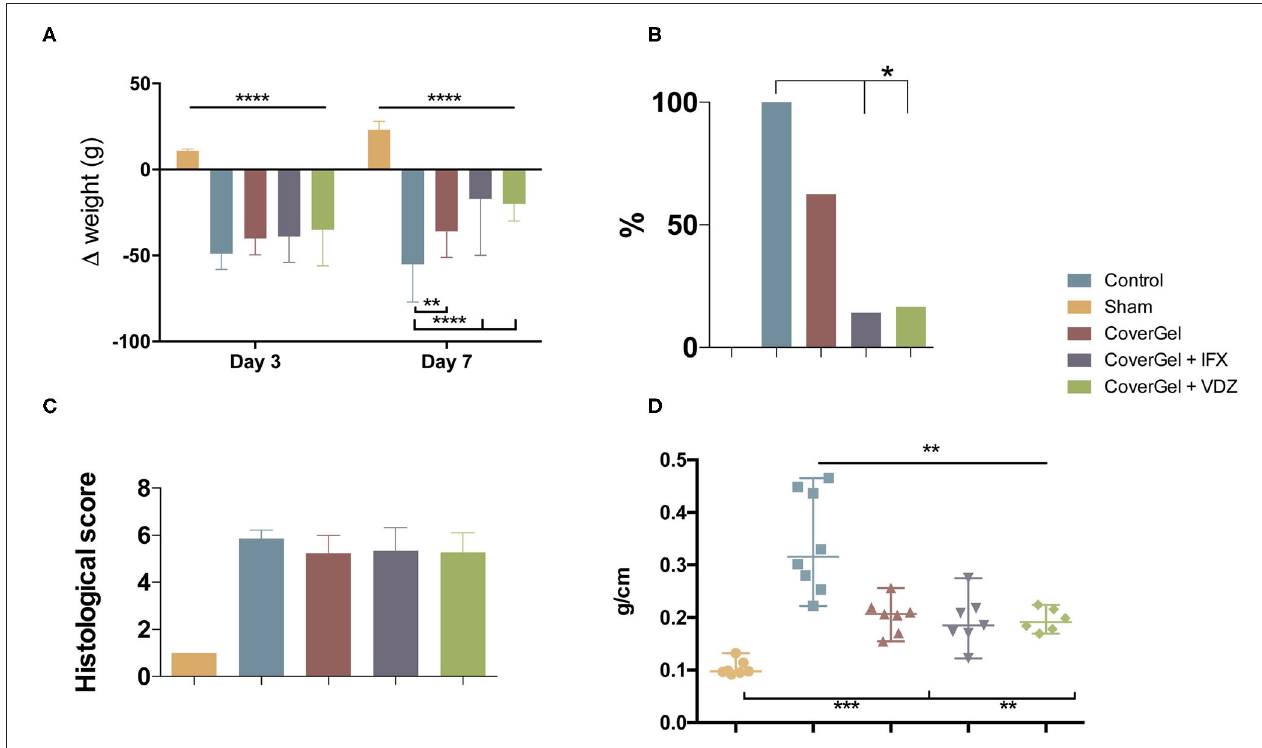
FIGURE 6 | Clinical evaluations on rats from the acute EC animal model. Color representations are as follows: Control group Sham group CoverGel group CoverGel + IFX group